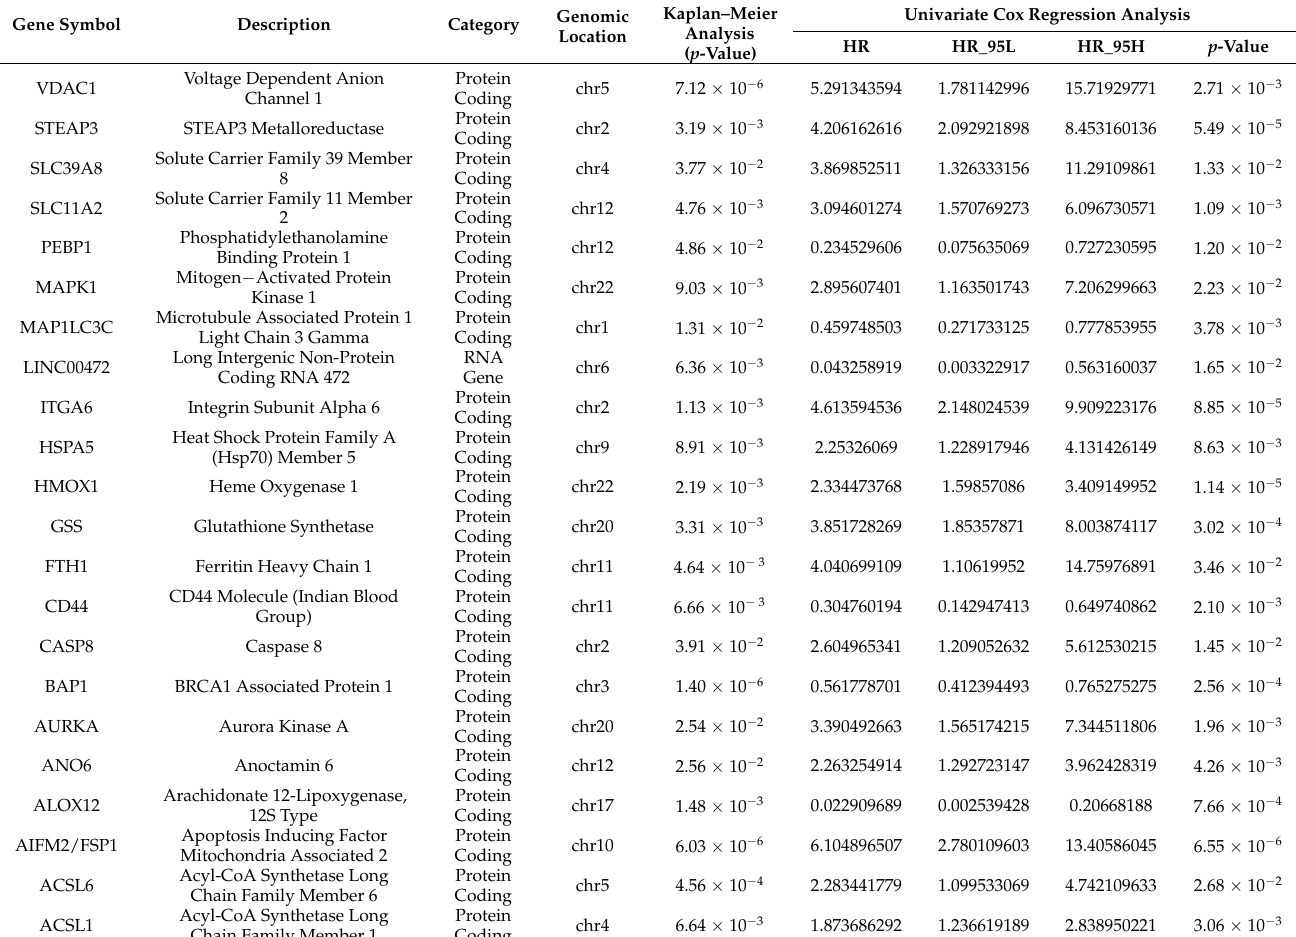
Table 2. 22 ferroptosis-related potential prognostic genes generated from the training cohort.